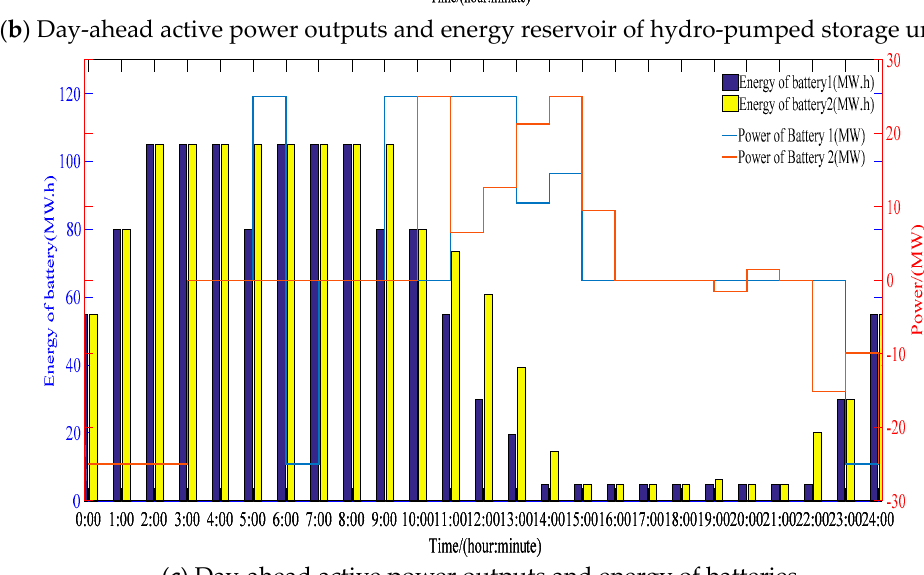
Figure 4. Day-ahead power generation plan.